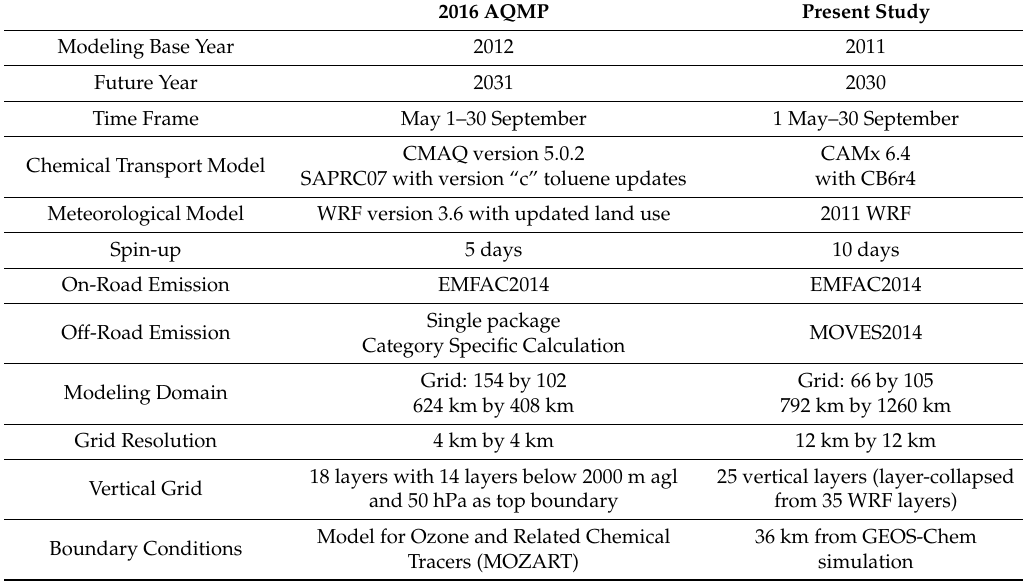
Table 4. Numerical modeling platforms and domains for 2016 Air Quality Management Plan (AQMP) and this